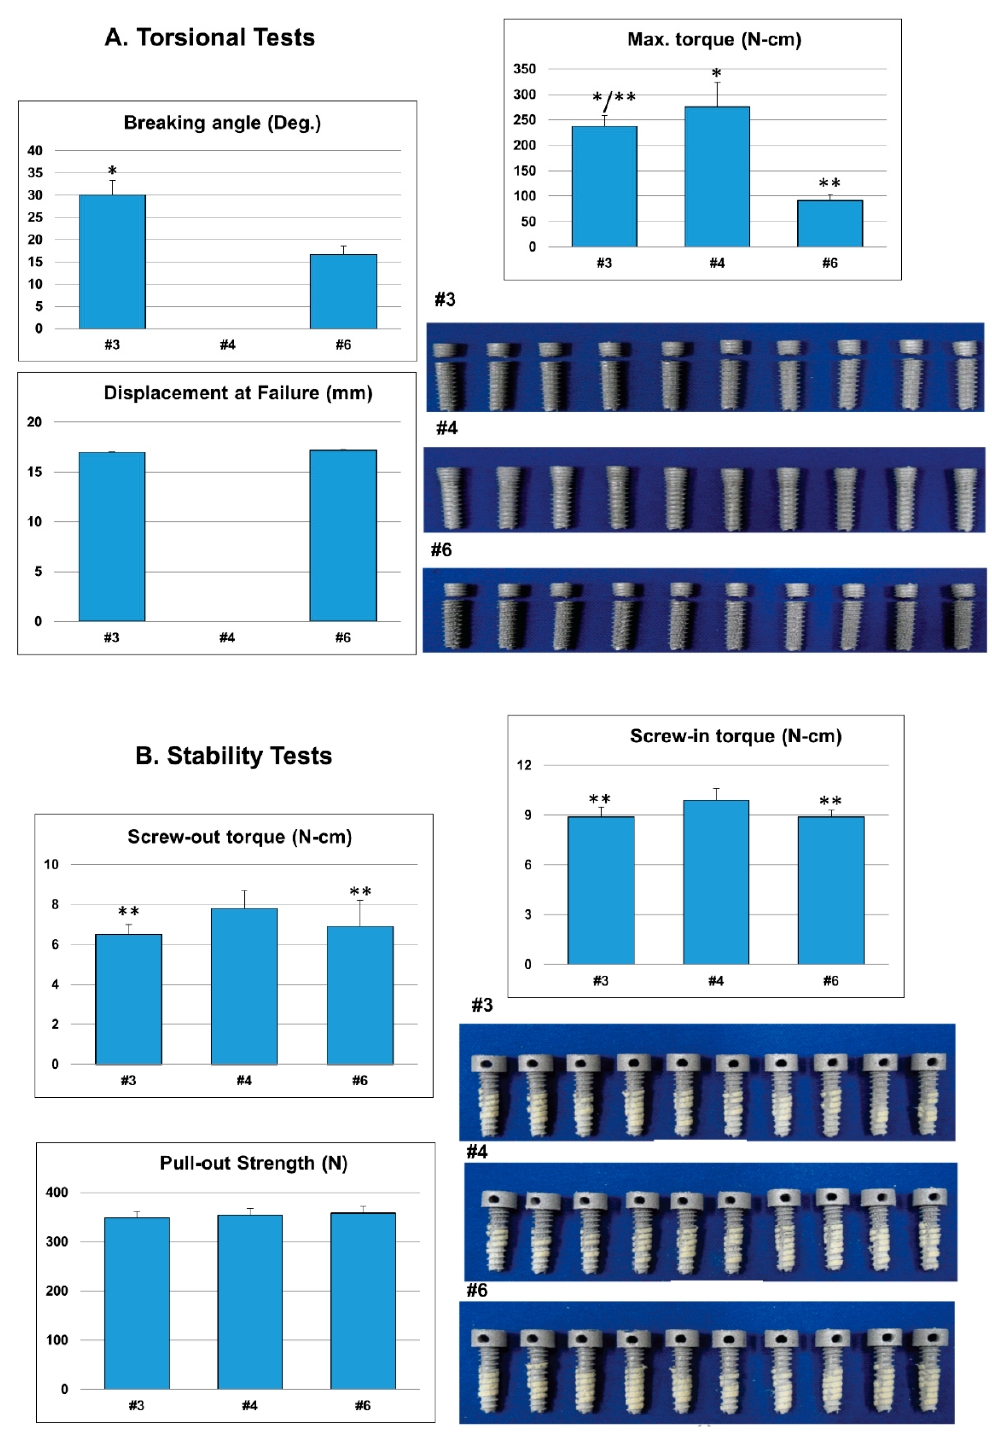
Figure 2. ( A ) Torsional and ( B ) stability tests of the biomimetic DMLS Ti 6 Al 4 V dental implants (n = 10). During torsional testing, the highest mean maximal torque value was obtained for the non-porous design. Throughout the entirety of the torsional experiments, type #4 dental implants (non-porous) did not break. During stability testing, the mean screw-in or screw-out torque was significantly higher for the non-porous design, while no significant differences existed in the pull-out strength among the three designs tested. (* indicates significant differences when compared to the #6 dental implant; ** indicates significant differences when compared to the #4 dental